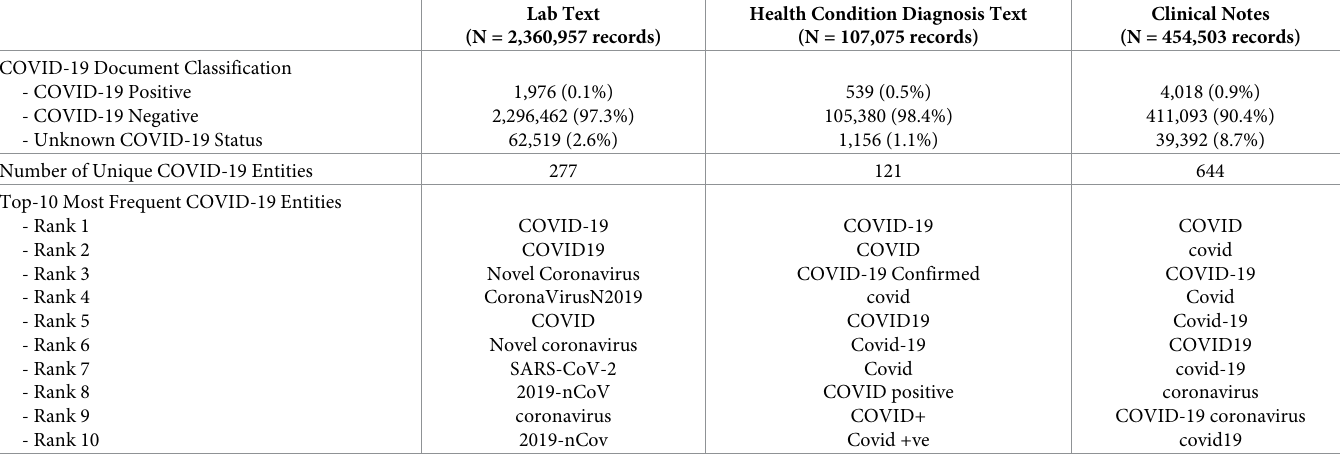
Table 2. COVID-19 document classifications and COVID-19 entities/tokens identified from each primary care clinical text stream: lab text, health condition diag- nosis text and clinical notes.